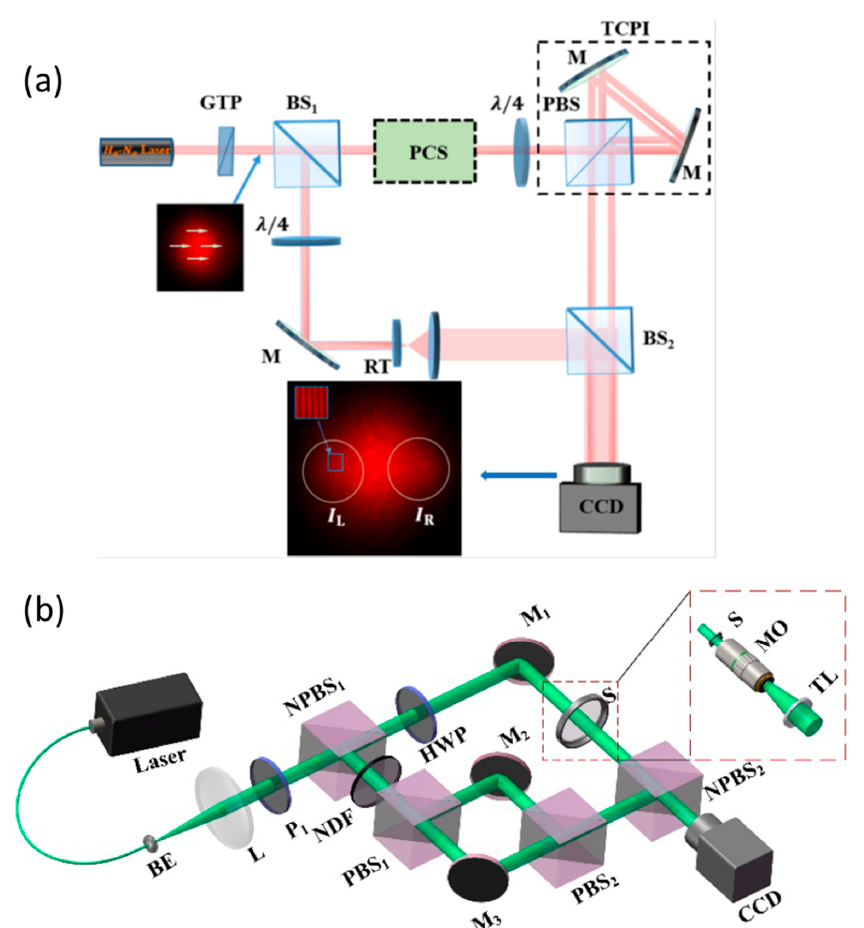
Figure 5. Experimental setup for polarization measurement—( a ) triangular common-path interferometer (TCPI). GTP: Glan–Taylor polarizer; BS1 and BS2: beam splitter; PCS: polarization conversion system; λ /4: quarter-wave plate; PBS: polarizing beam splitter; M: mirror; RT: reversed telescope; CCD: charge-coupled device. The elements inside the dashed box form a TCPI (Reproduced with permission from Qi et al. [40], AIP, 2019); ( b ) schematic of the PAMDH system based on the geometric phase. BE: beam expander; L: lens; P: polarizer; S: sample; HWP: half-wave plate; NPBS 1 - NPBS 2 : non-polarized beam splitters; PBS 1 -PBS 2 : polarized beam splitters; M 1 -M 3 : mirrors; NDF: neutral density filter; MO: microscope objective; TL: tube lens (reprinted from Dou et al. [47]).